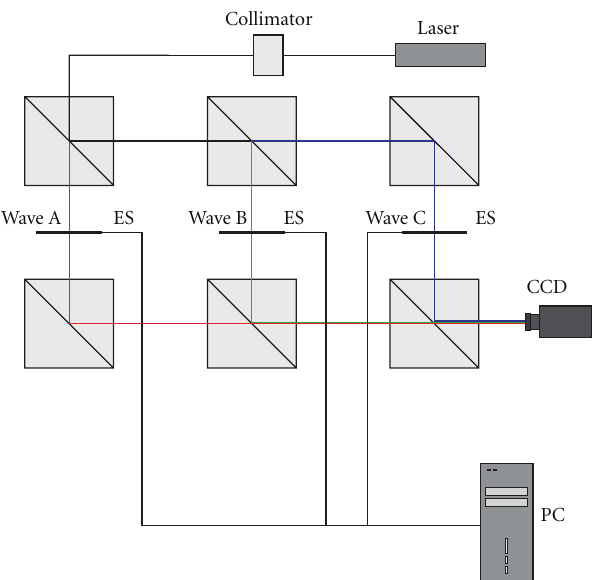
Figure 1: Six cubic beam splitters generate a set of three plane waves: A , B , C . These beams interfere and generate regular lattice of optical vortices. ESs are electronic shutters, which enable to capture the following interferograms: A + B , A + C , B + C , A + B + C . The electronic shutters are not necessary when using one-frame ( A + B + C ) measurement procedure.